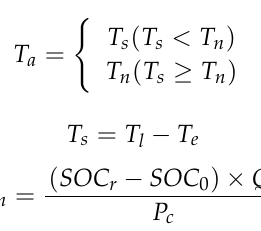
Figure 6. Probability distribution of the initial SOC.